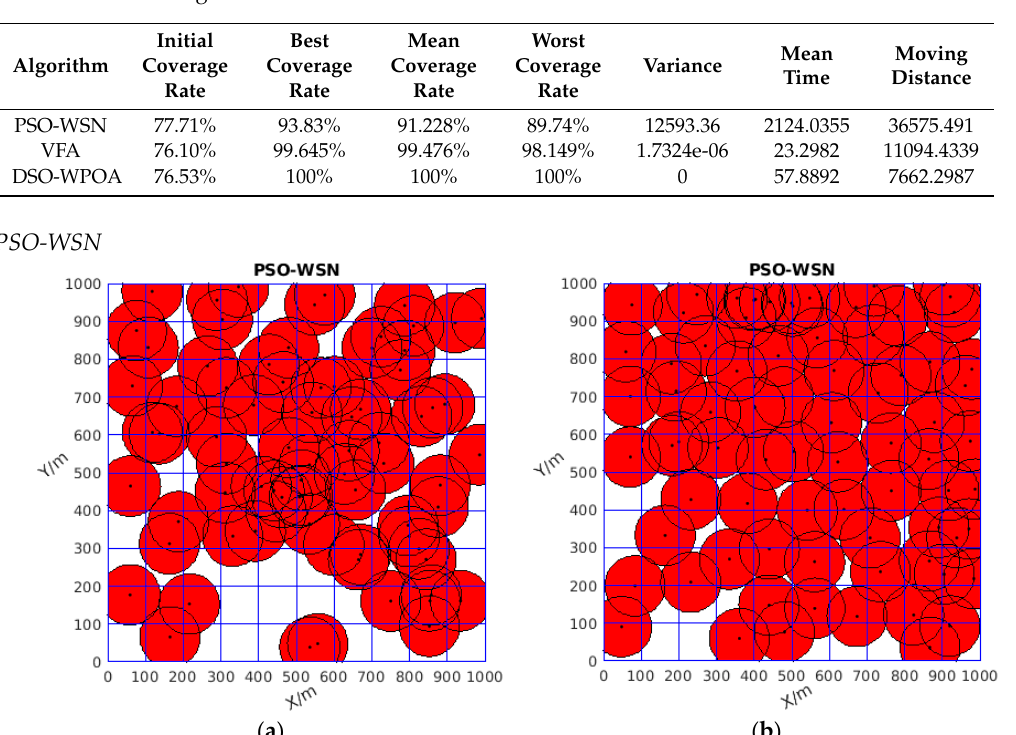
Table 1. Results of experiments. PSO-WNS: particle swarm optimization-wireless sensor network;